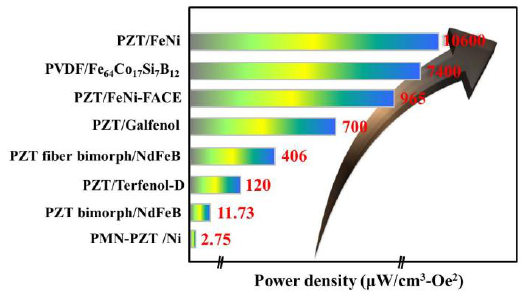
Figure 13. Summary of reported power densities from the MME harvesters made with different composite systems. Data are from references [94,96–105].